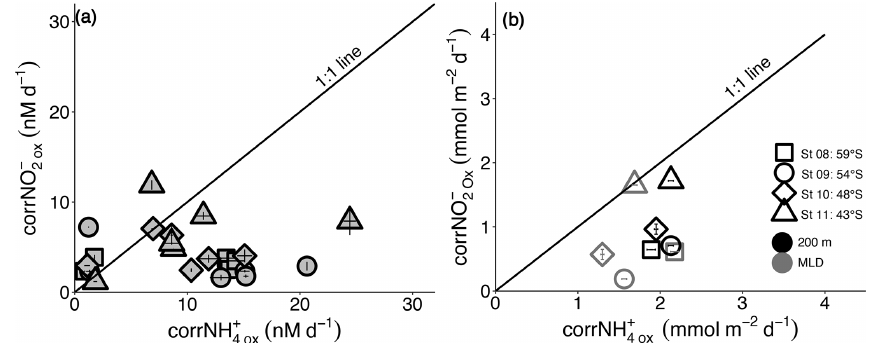
Figure 6. The relationship between the revised rates of NO − in the upper water column (0–500m) and (b) integrated over the mixed layer (grey symbols) and upper 200m (black symbols). Error bars in (a) indicate the range of values, each measured at least twice, while in (b) , error bars show the propagated error. Where errors bars are not visible, they are smaller than the data markers. The black diagonal line in both panels has a slope of 1, which is expected if the rates of NH + and NO − oxidation are tightly 2